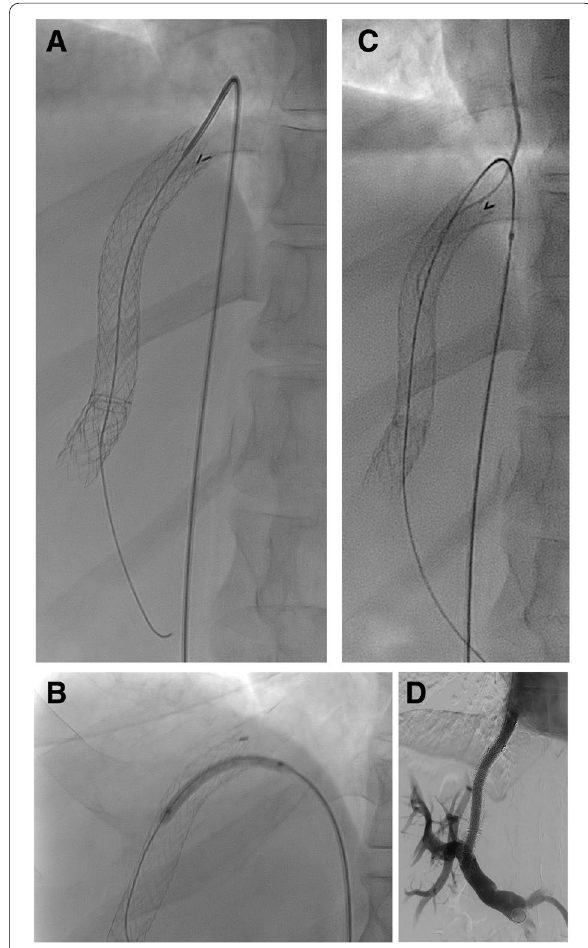
Fig. 1 Recanalization of occluded intrahepatic portosystemic covered stent in a 41-year-old patient with Budd-Chiari syndrome where the transjugular approach was not feasible. A Transfemoral insertion of a reverse-curve catheter (5 Fr Simmons 1 catheter; Cordis) into the right liver-vein ostium. A hydrophilic guide wire (Terumo, Japan) was used to cross the occlusion, while maintaining tension on the catheter to ensure support while manipulating the wire through the occlusion. B Next, PTA was performed using a 4 mm balloon via the femoral access, which then C enabled transjugular insertion of a 4 Fr Vertebralis catheter into the TIPS/portal system; which had not been possible before. D Post-procedure portal venogram shows the restoration of the shunt function after balloon angioplasty and implantation of an additional